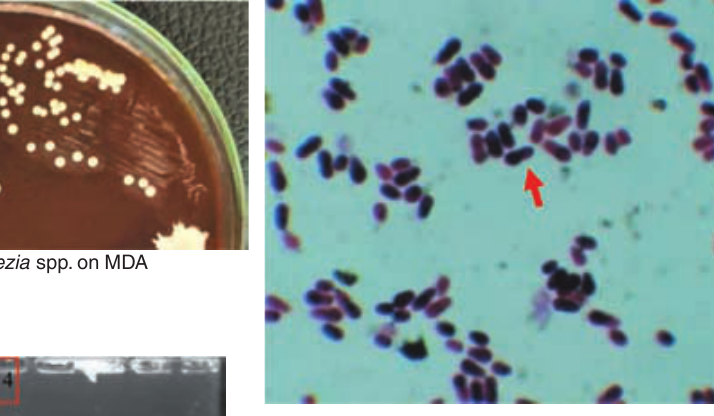
Fig. 3. Microscopic examination of colonies of Malassezia spp. using Gram’s staining